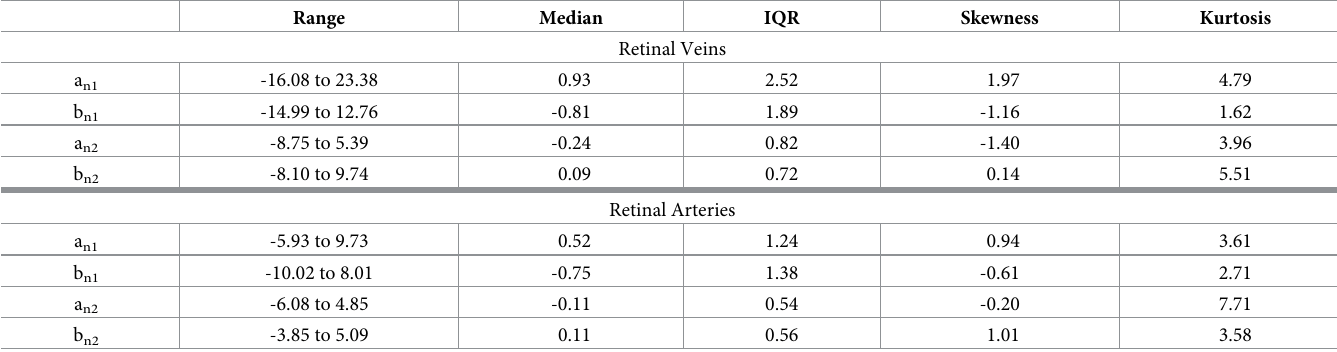
Table 2. Dispersion and central tendency of the coefficients of the first two harmonics of the retinal arteries and